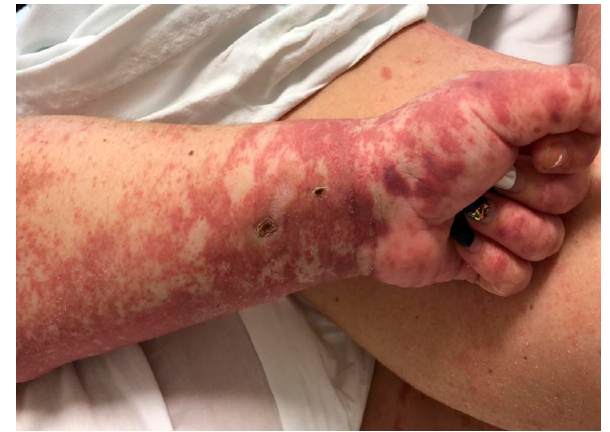
Figure 1. Vasculitic lesions on hands and forearms.